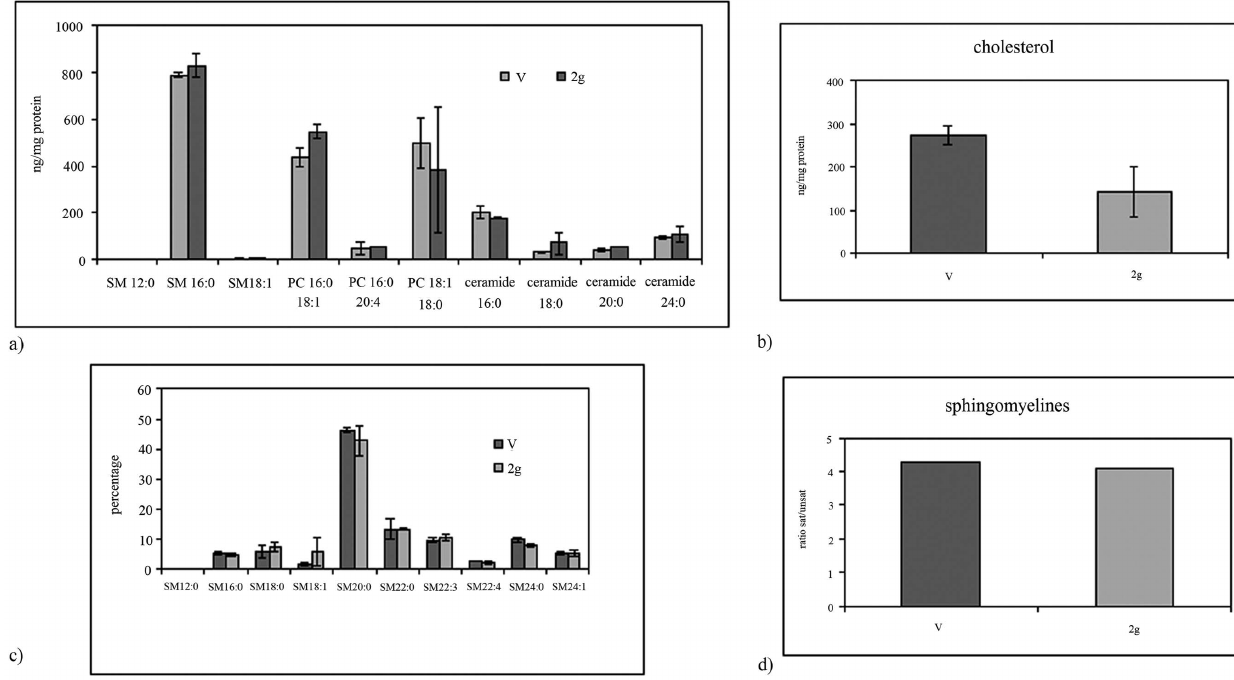
Figure 4. Lipid behavior in hypergravity. Lipid fraction of thyroid tissue in vivarium (V) and hypergravity (2 g) mice. a) amount of specific sphingomyelin (SM), phosphatidylcholine (PC) and ceraminde species; b) cholesterol (CHO) content; c) comparison of areas of different SM species; d) ratio of saturated/unsaturated SM species. The experiment was performed in left lobes of thyroid glands. Data represent the mean 6 S.D. of 4 2 g mice and 3 V mice. Significance, *P , 0.001 2 g versus V